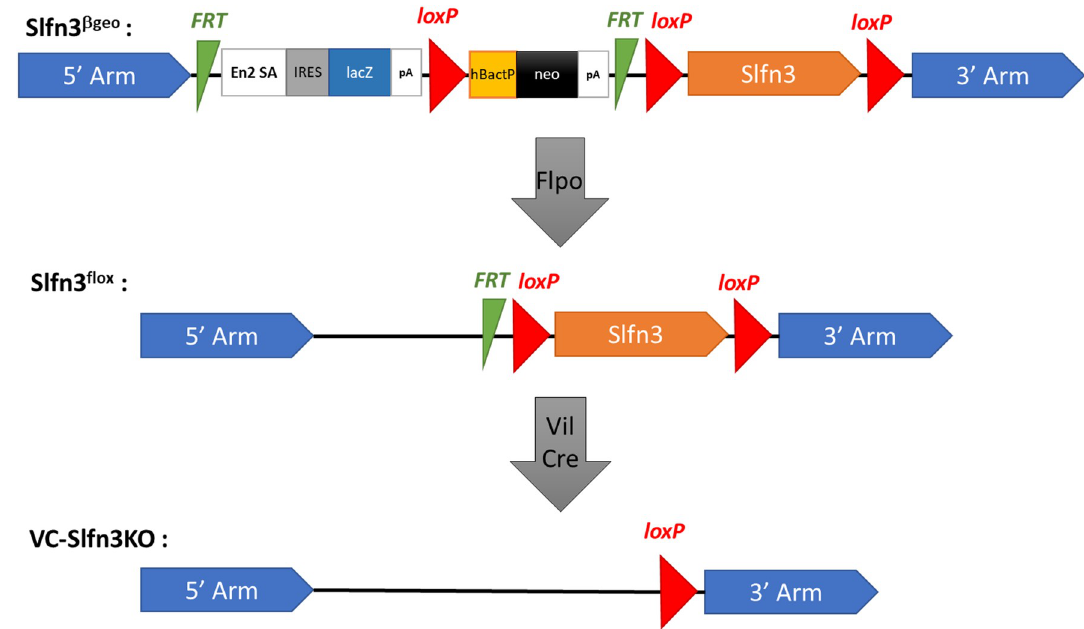
Fig 1. Gene targeting scheme for generating VC-Slfn3KO mice. The Slfn3 β geo mice had a knockout first, lacZ -tagged insertion, and conditional allele of Slfn3. These mice were bred with B6.129S4- Gt(ROSA)26Sor tm2(FLP � )Sor /J (Flpo) mice, resulting in Slfn3 flox mice. The Slfn3 flox mice were then bred with B6.Cg-Tg(Vil1-cre)1000Gum/J (VilCre) mice to create VC-Slfn3KO